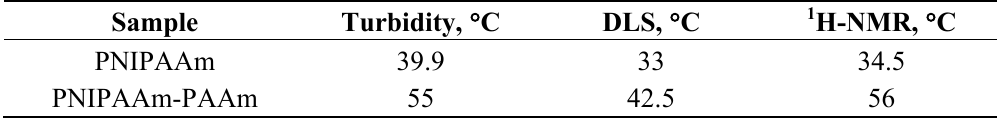
Table 6. LCST of PNIPAAm (Table 1, Ratio 100:1:2:2) and PNIPAAm-PAAm (entry 4, Table 2) determined by turbidity, DLS and 1